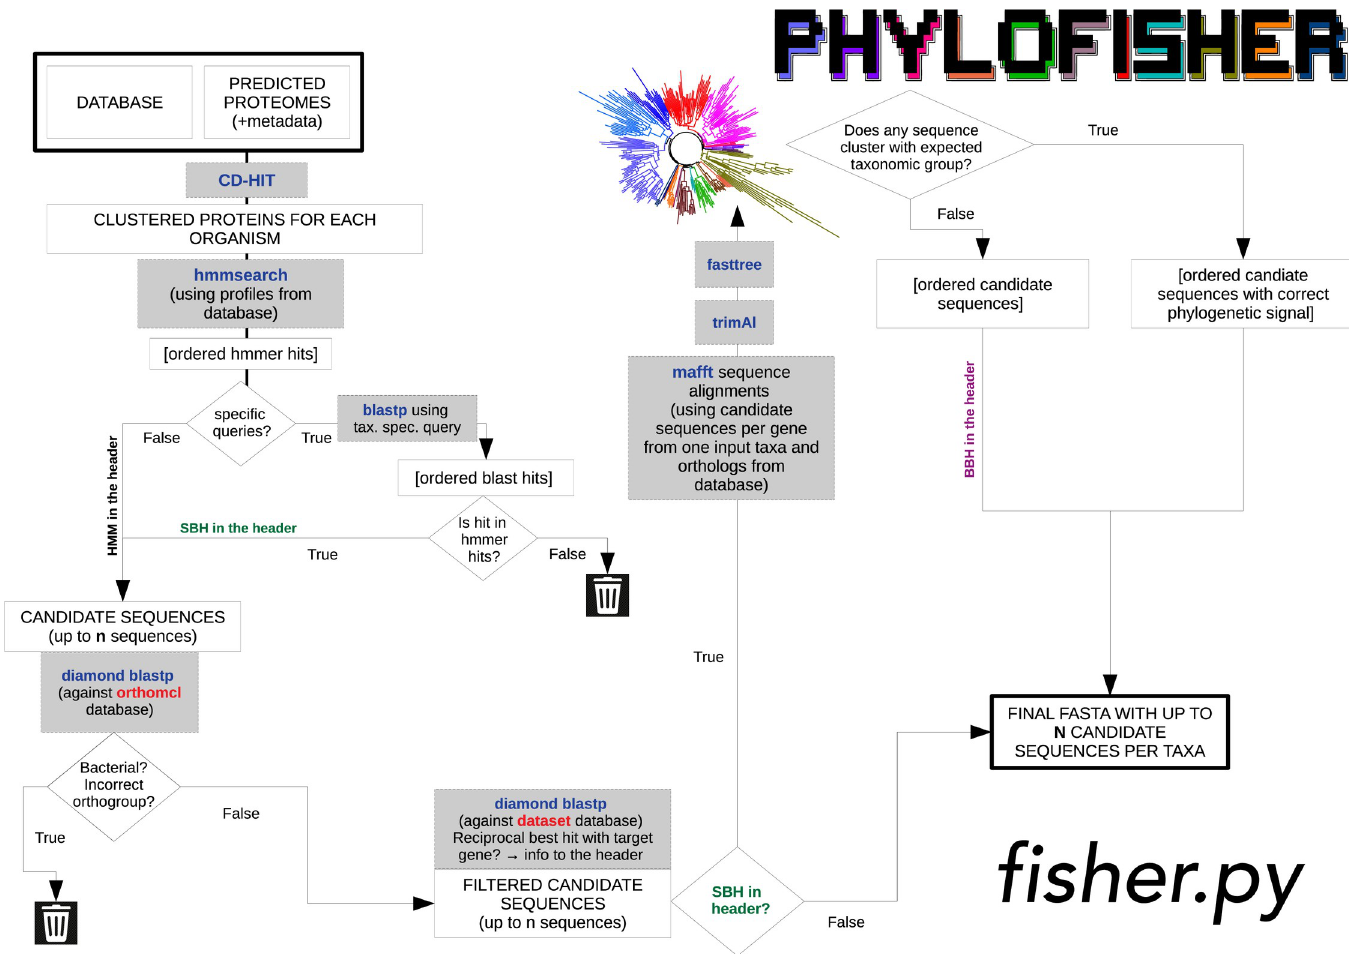
Fig 2. Flowchart of homolog collection performed by the PhyloFisher Python script fisher . py . Briefly, each predicted proteome of a new taxon to be added is processed through either a default route or a phylogenetically aware route that utilizes the manually curated orthologs from closely related taxa chosen by the user (and present in the starting database) as search queries against the proteome of the new taxon. Up to a user-defined number of collected sequences are reprioritized or eliminated based on a set of criteria designed to maximize correct demarcation of the desired ortholog and related paralogs while avoiding contaminating sequences. See Supporting information Materials and methods for a detailed description of the logic, third-party software, and associated parameters